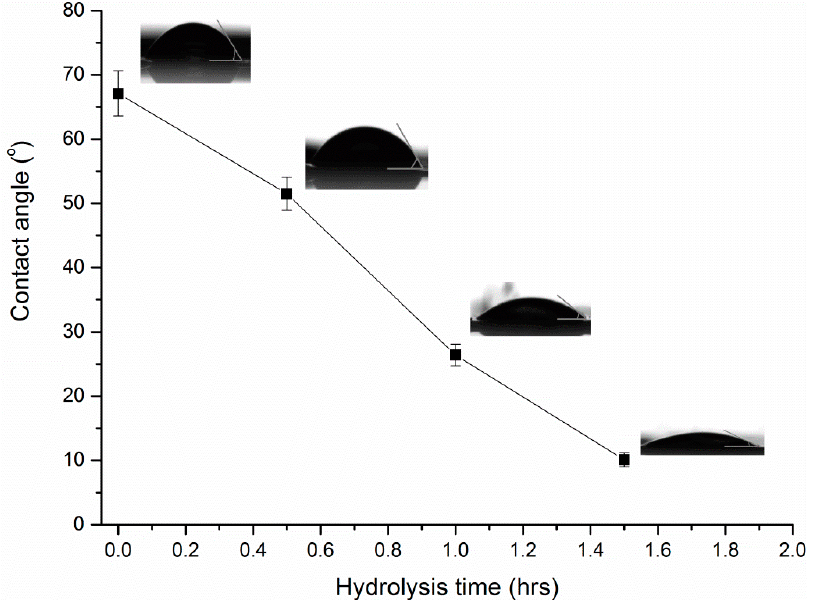
Figure 5. (•) Water and ( ■ ) –COOH mass loss ( w / w %) of PAN membranes as a function of hydrolysis time, and thermogravimetric curves of hydrolyzed PAN membranes for the more representative hydrolysis times.